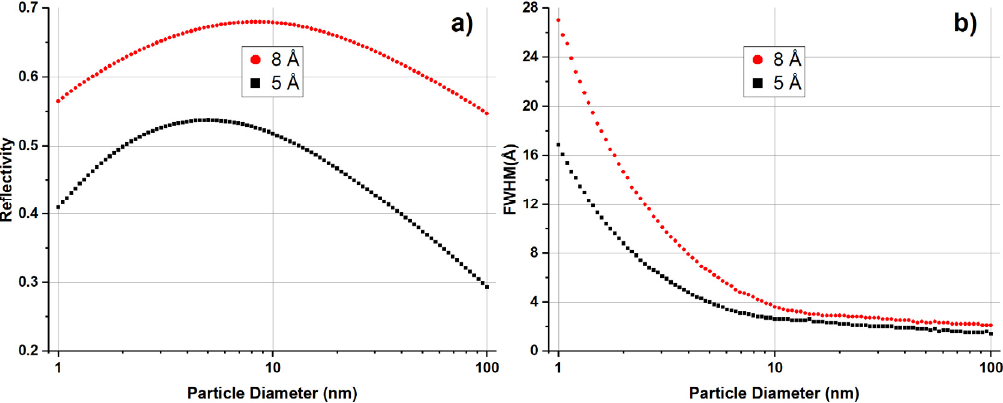
Figure 11. ( a ) Simulated reflectivity and ( b ) angular distribution width as a function of ND diameter. Black squares correspond to calculations for neutrons with wavelengths of 5 Å, and red circles correspond to 8 Å. The angle of incidence was set to 1° in the simulations.